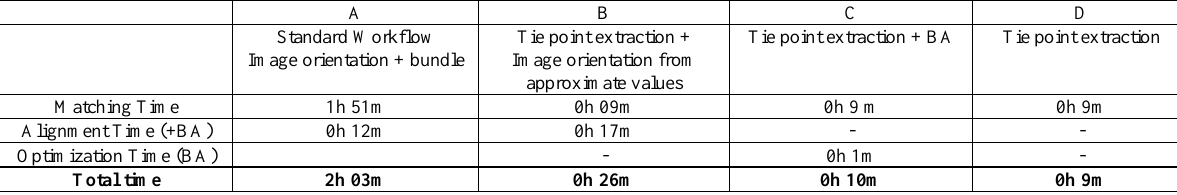
Table 3 . Computation times for the different processing strategies in the case study shown in Figure 12. See subsection 4.3 for further details.